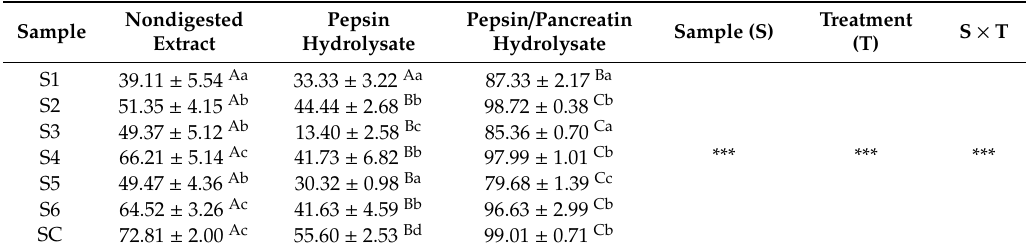
Table 4. Results of radical scavenging activity against ABTS • +